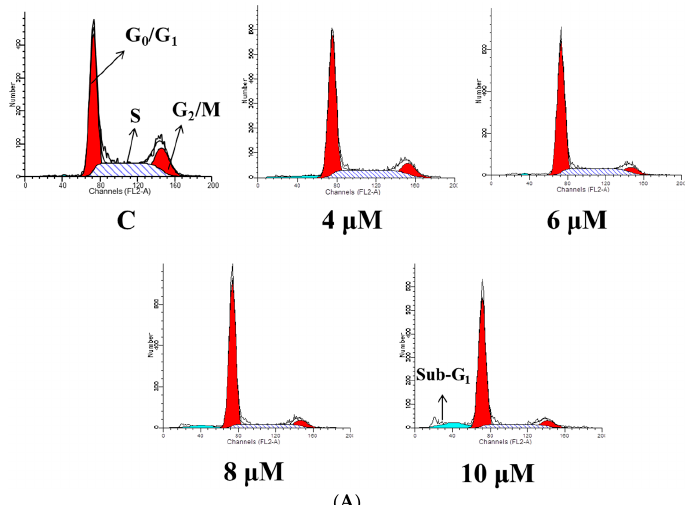
Figure 2. TET induces nuclear chromatin condensation in NPC-TW 076 cells . Cells were treated with 0, 4, 6, 8 and 10 μ M of TET for 48 h and then were stained with DAPI as described in Materials and Methods. Cells were examined and photographed using a fluorescence microscope at 200× ( A ) and the DAPI fluorescence intensity were quantified ( B ). * p < 0.05, significant difference between TET-treated groups and the control as analyzed by Student’s t test.